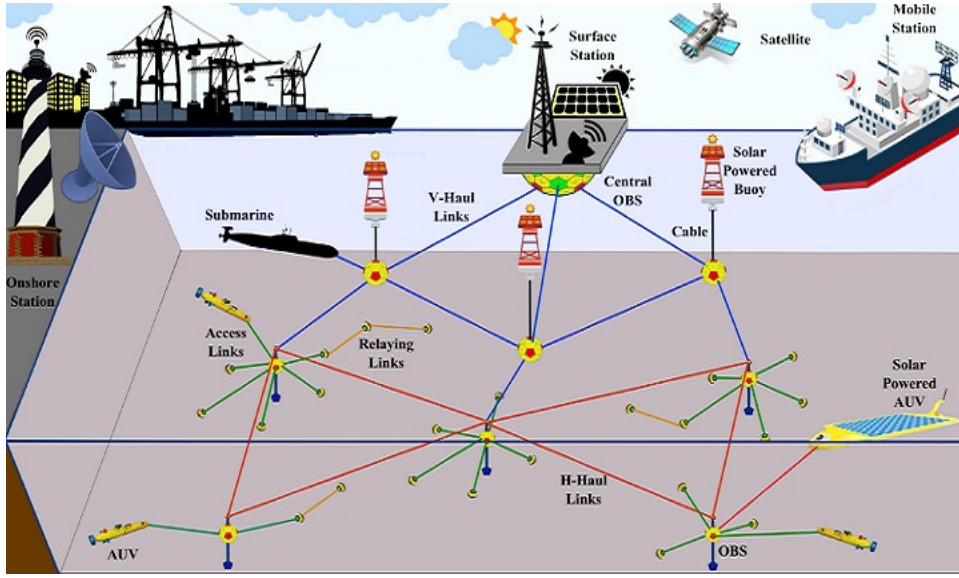
Figure 2. Underwater Sensor System Architecture.